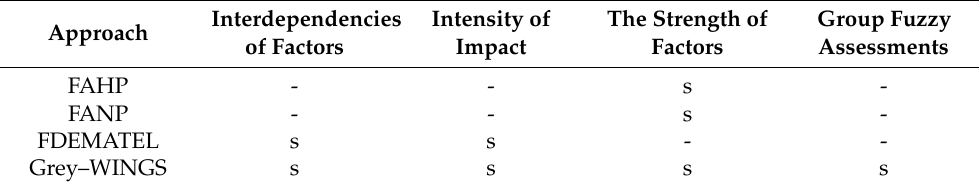
Table 2. Comparations within different